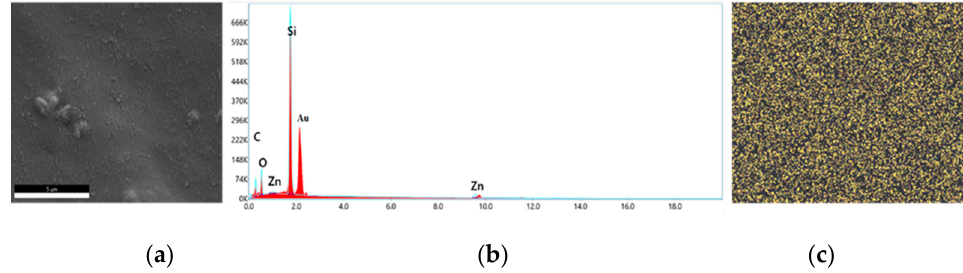
Figure 5. ( a ) SEM micrographs of modi fi ed ZnO NPs grafted silicone (SR-g-AAc-ZnO) operated at 15 kV; ( b ) Results of SEM- Energy Dispersive X-ray Spectroscopy (EDX) spectrum prove the suc- cessful modi fi cation of silicone by ZnO NPs, ( c ) SEM-EDX mapping at a magni fi cation of 16.00 KX modification of silicone by ZnO NPs, ( c ) SEM-EDX mapping at a magnification of 16.00 KX showing a homogenous coating of ZnO NPs (yellow dots on the fi gure) as proof of successful mod- i fi cation.